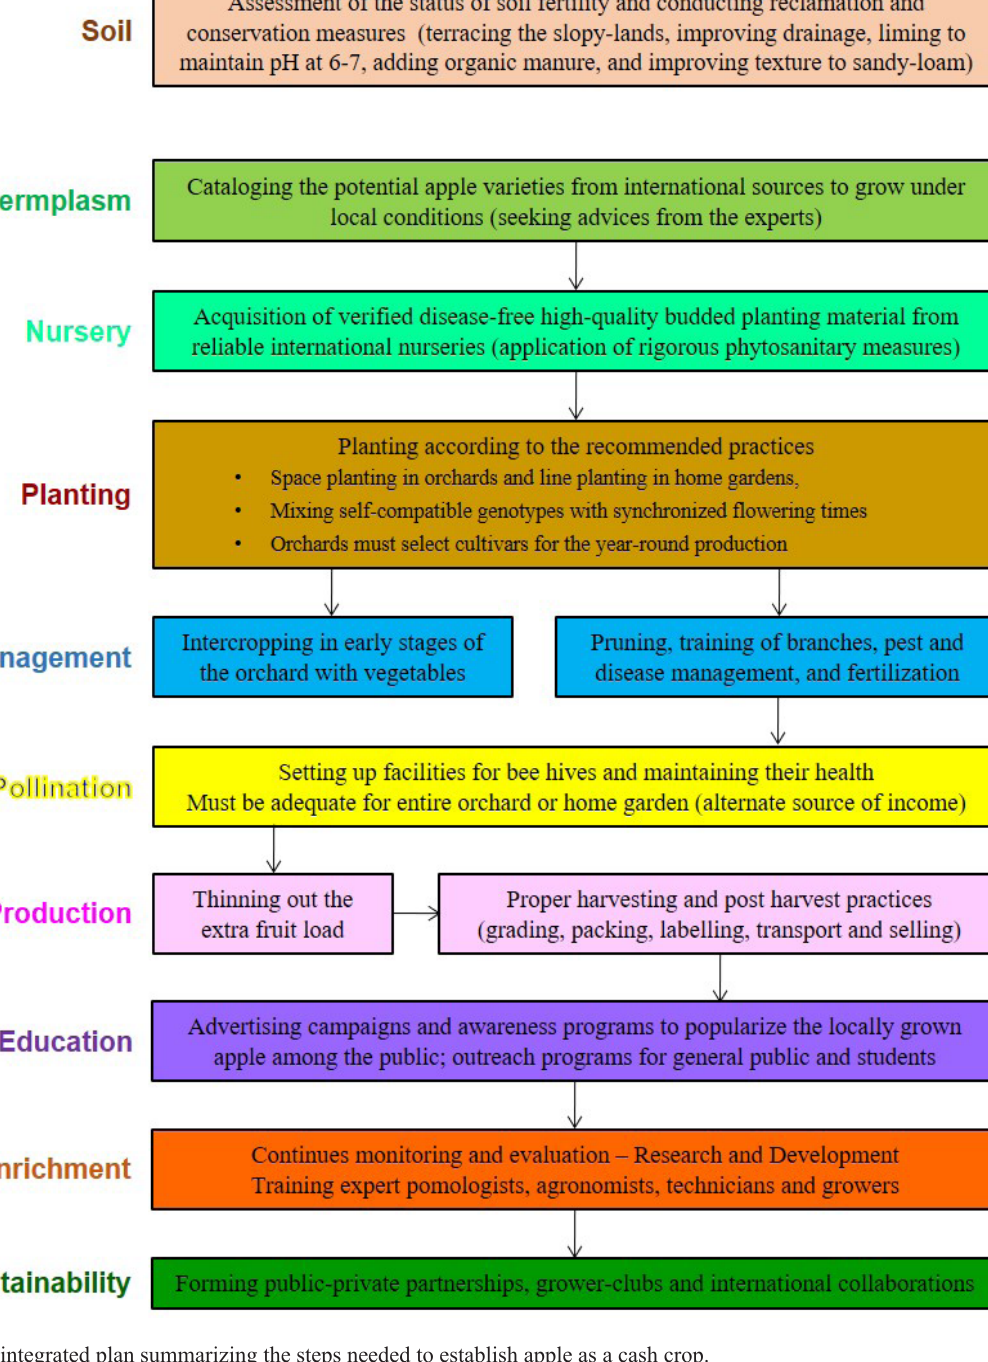
Figure 7: An integrated plan summarizing the steps needed to establish apple as a cash